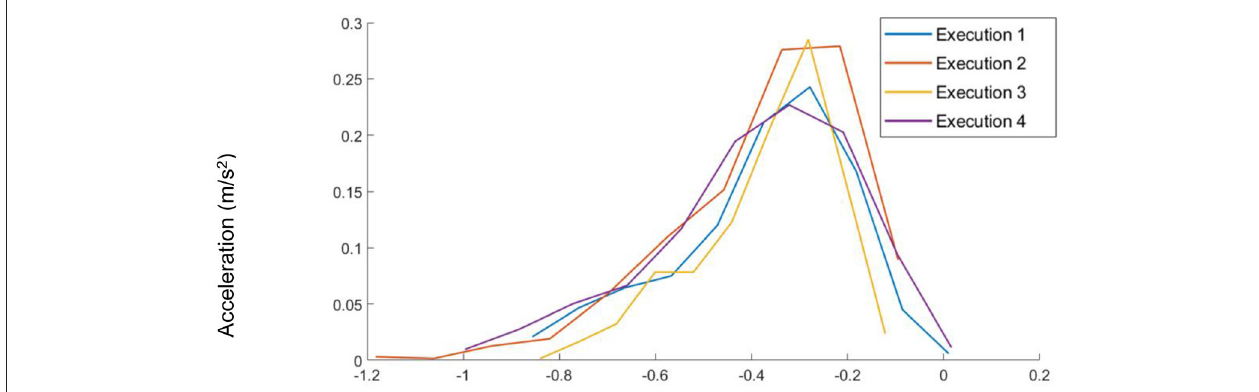
FIGURE 2 | The distributions for non-normalized raw input data from the Y-axis Accelerometer for multiple executions of the same activity by the same subject. In this case, the variance is reasonably low.